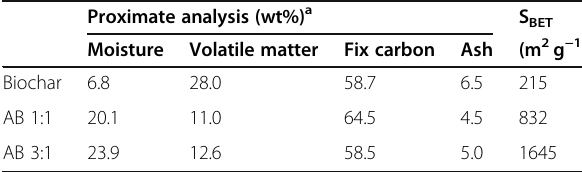
Table 3 Physicochemical characteristics of activated